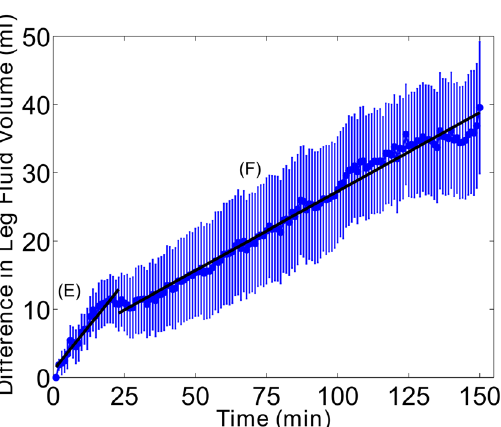
Figure 2. Mean difference in leg fluid accumulation between the active and sham ES conditions over the 150 minute seated period with standard error bars. The temporal pattern of differences in leg fluid accumulation between study conditions shows steady increase as sitting time progresses, and the rate of increase was different between the initial and latter portions of sitting. The models representing the initial and latter portions of the difference in fluid volume are described by equations E and F. F: LFV ( t ) = 0.52 t + 1.0. E: LFV ( t ) = 0.23 t +